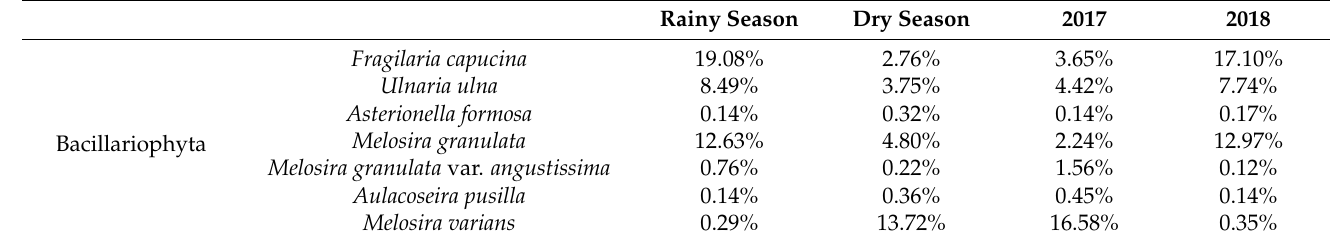
Table 3. Relative abundance of dominant species of phytoplankton in Jingpo Lake from 2017 to